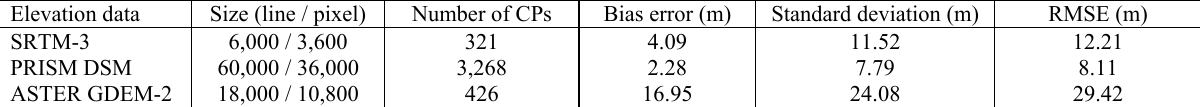
Figure 4. Visual comparison of PRISM DSM (0.3 arcsec, left), ASTER GDEM-2 (1 arcsec, middle) and SRTM-3 (3 arcsec, right) for the same area. The red lines show administration boundaries, and blue dots represent the locations of several CPs in 2011. Table 1. Summary of validation results using ground-based GPS measurements among SRTM-3, PRISM DSM mosaic, and ASTER GDEM-2 in the Bhutan